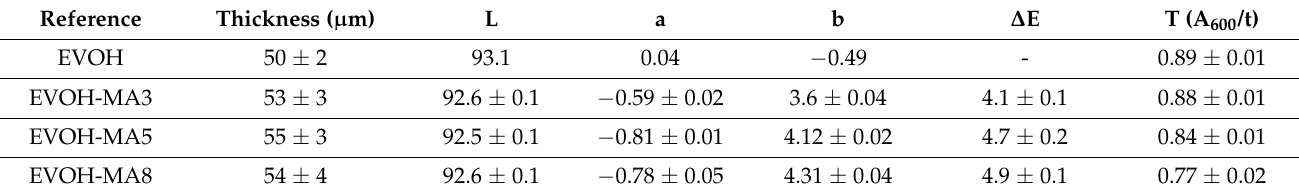
Table 4. Thickness, colour parameters and transparency of extruded EVOH-based